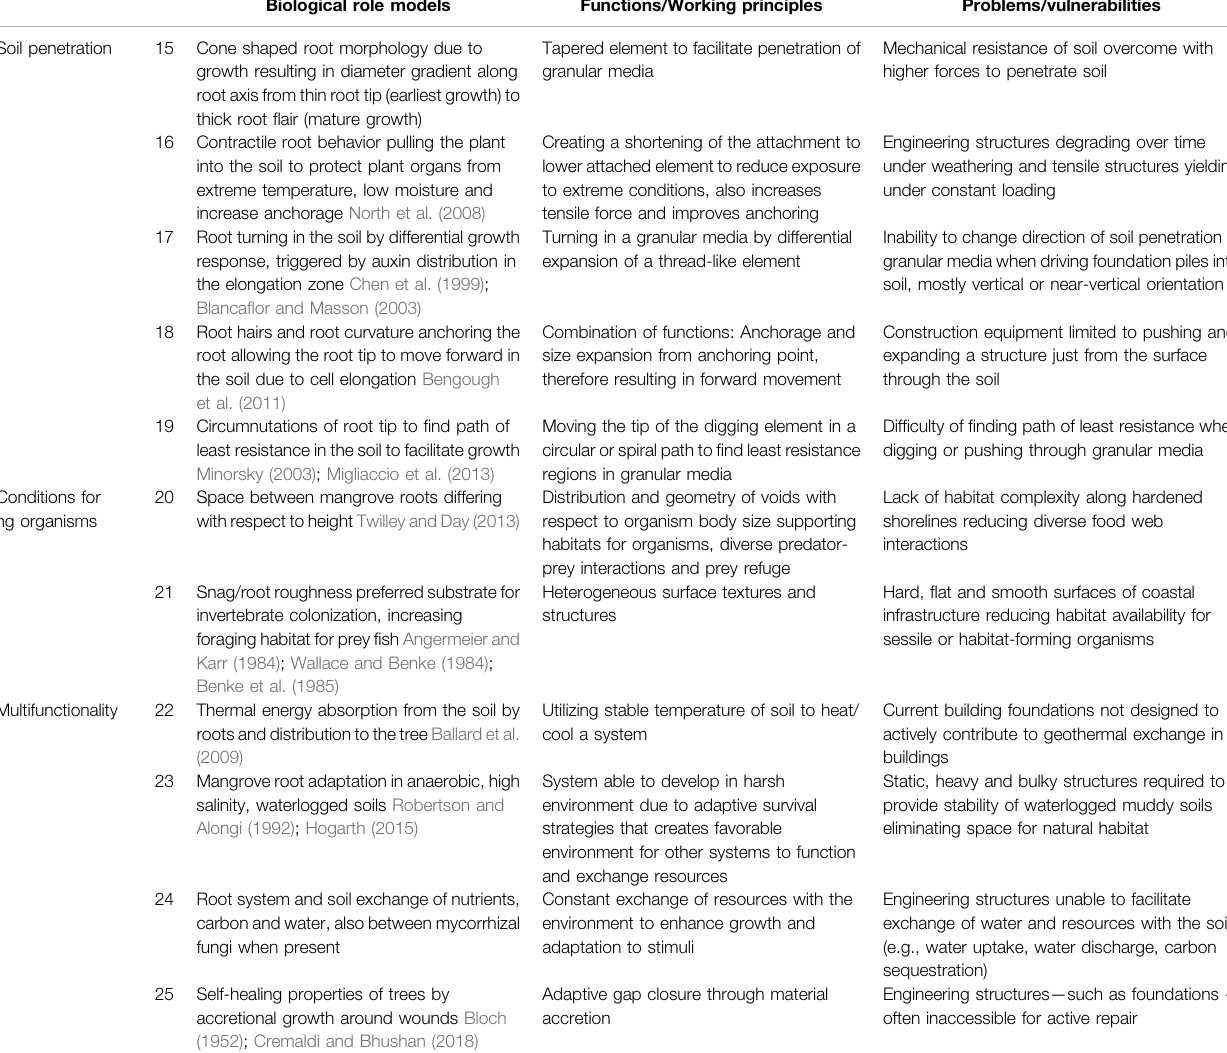
TABLE 1 | ( Continued ) Analogy table ( “ Abstraction and Analogy ”